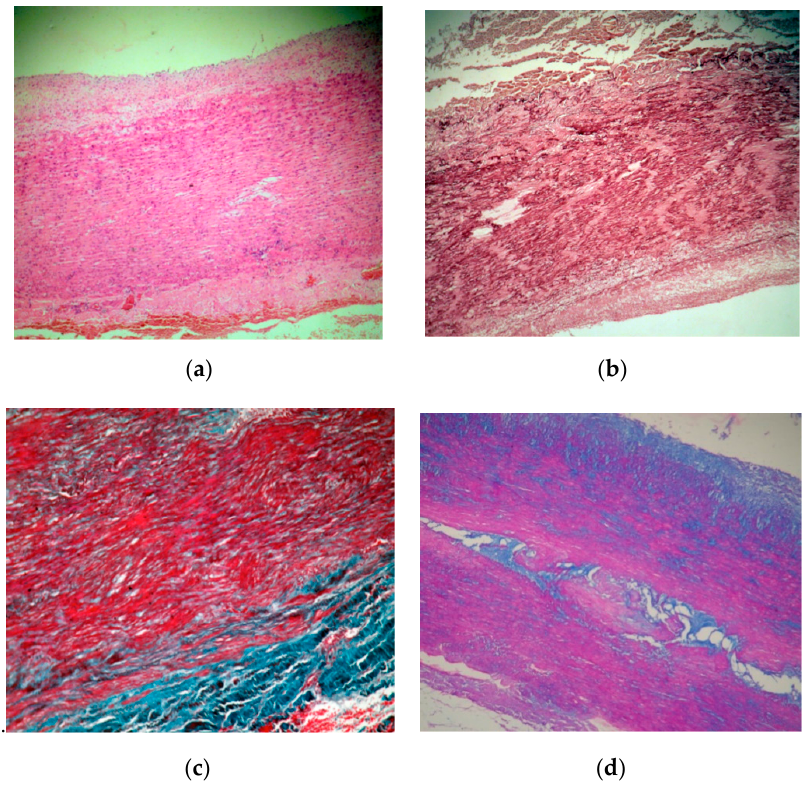
Figure 5. ( a ). A hematoxylin–eosin (HE) stain ×5 aorta with major medial changes, corresponding